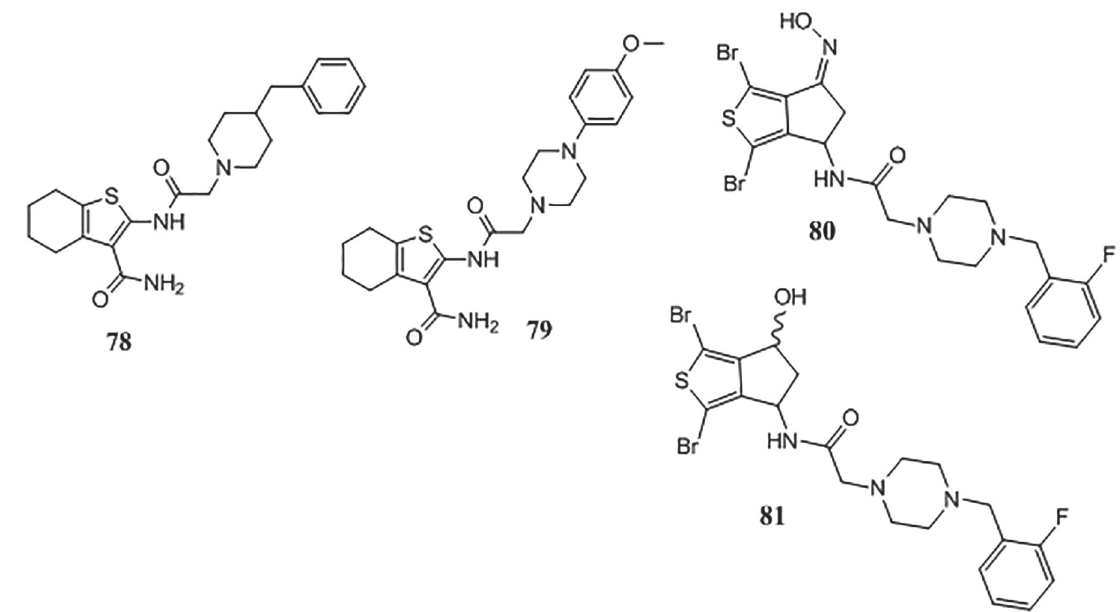
FIGURE 12 - Donepezil derivatives having condensed heterocyclic